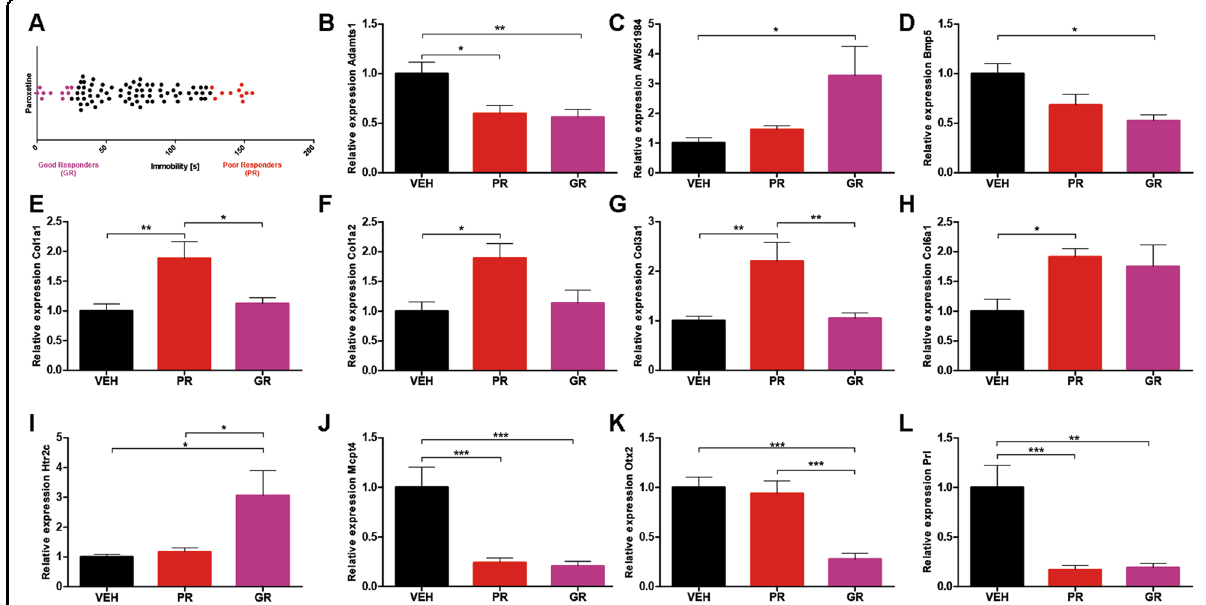
Fig. 4 Validation of genes differentially expressed between of good and poor responders. A Paroxetine-treated animals and strati fi cation in good and poor responder mice using the forced swim test ( n = 90). B – L qPCR validation of 11 selected genes of interest (one-way ANOVA, Bonferroni ’ s Multiple Comparison Test). B Adamts1 : F = 6.883, p = 0.0038. C AW551984 : F = 3.917, p = 0.326. D Bmp5 : F = 6.272, p = 0.0062. E Col1a1 : F = 6.532, p = 0.0049. F Col1a2 : F = 5.174, p = 0.0125. G Col3a1 : F = 8.448, p = 0.0014. H Col6a1 : F = 3.718, p = 0.0375. I Htr2c : F = 5.309, p = 0.0123. J Mcpt4 : F = 12.39, p = 0.0002. K Otx2 : F = 16.52, p < 0.0001. L Prl : F = 11.93, p = 0.0002. VEH vehicle, GR good responder, PR poor responder, bars with mean and SEM. * p < 0.05; ** p < 0.01; *** p <